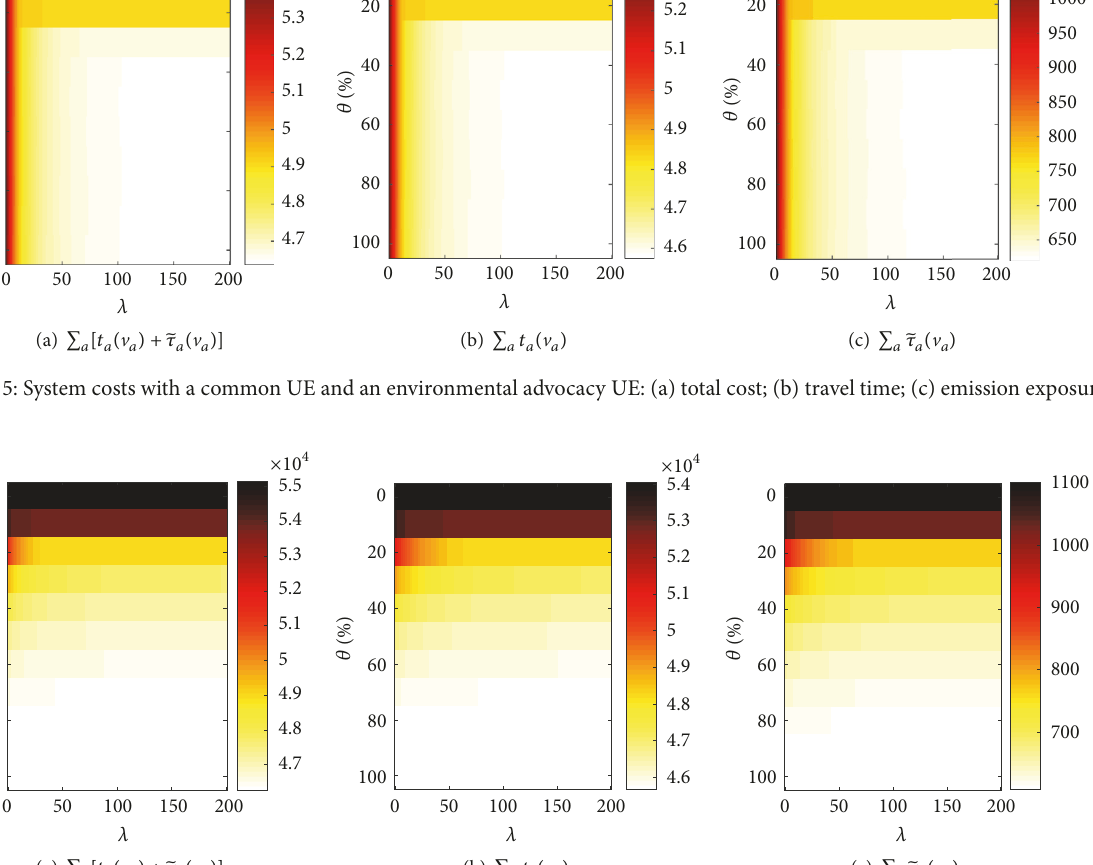
emission exposure (e.g., 𝜆 ≥ 50 ), the cooperative